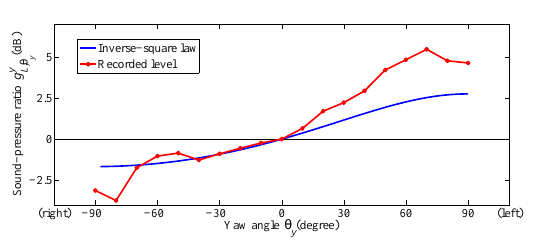
Figure 8. Empirical and theoretical q y –gain model for the left channel